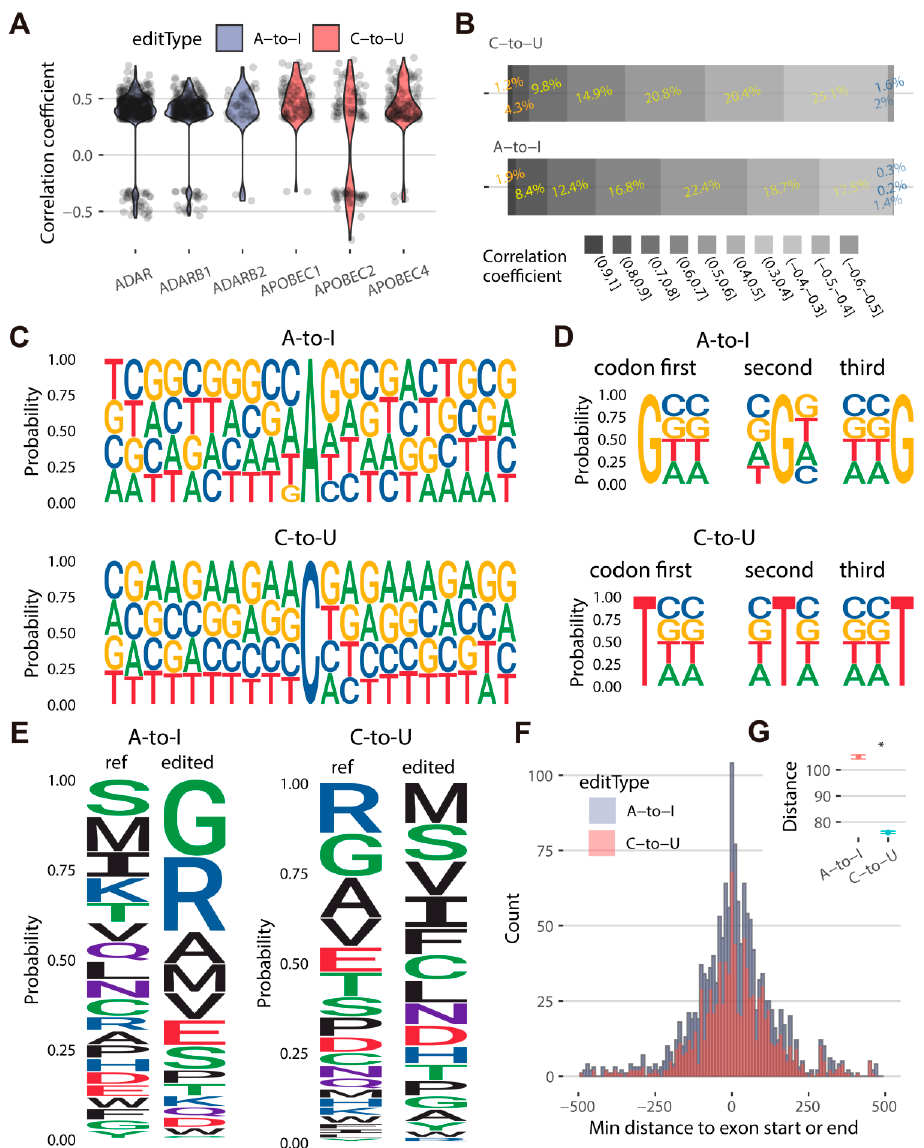
Figure 3. Functional characterization of goat A-to-I and C-to-U editing. ( A ) The correlation coefficient between the editing levels of A-to-I or C-to-U sites and the expression levels of catalyzing genes ( ADAR , ARARB1 , ADARB2 , APOBEC1 , APOBEC2 , and APOBEC4 ). ( B ) The correlation coefficient between the editing levels of A-to-I or C-to-U sites and the expression of RNA editing-related genes. ( C ) Sequence preferences for base flanking ( − 10, +10) A-to-I and C-to-U editing sites detected. The letter height indicates the level of preference or depletion. ( D ) Codon sequence preferences of A-to-I and C-to-U editing sites. The letter height indicates the level of preference or depletion. ( E ) The encoded amino acids changed after A-to-I and C-to-U editing. ref indicates reference amino acid (unedited), edited indicates A-to-I and C-to-U edited amino acid. ( F ) The distribution of distance from A-to-I or C-to-U sites to exon start or end. ( G ) Comparing the minimal distances to the exon boundary of A-to-I and C-to-U sites to assess alternative splicing activity. * indicates p < 0.05. 2.3. TBG Shows Higher A-to-I and C-to-U Editing Levels Than IMG in the Kidney To systematically investigate the RNA editing profiling of four tissues (heart, lung, kidney, and longissimus dorsi muscle) from TBG and IMG, we generated a pairwise com-